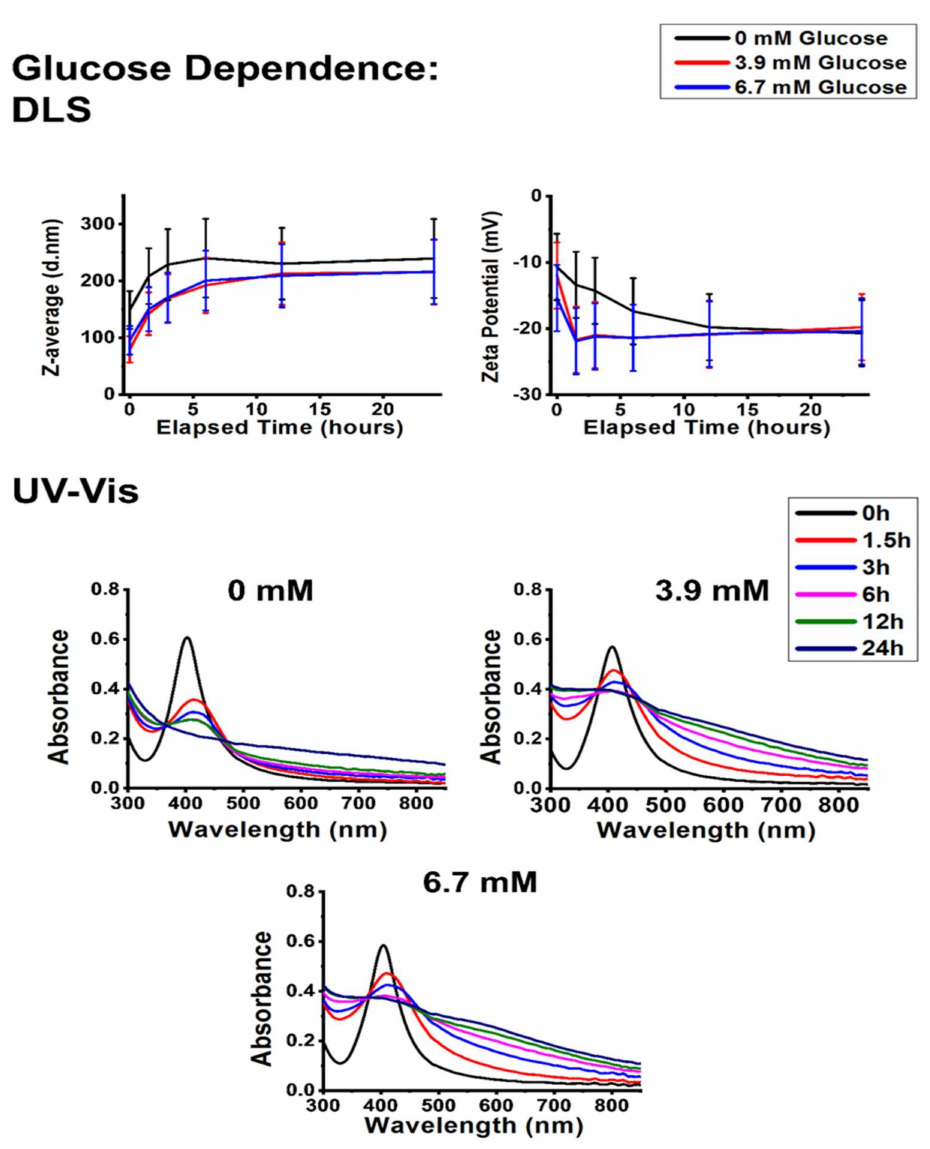
Figure 5. Dynamic light scattering (DLS) results (top), represented as average hydrodynamic diameter (Z-average) and zeta potential changes, and UV–Vis absorbance spectra (bottom) of polyvinyl- pyrrolidone-stabilized silver nanoparticles over 24 h under physiological glucose